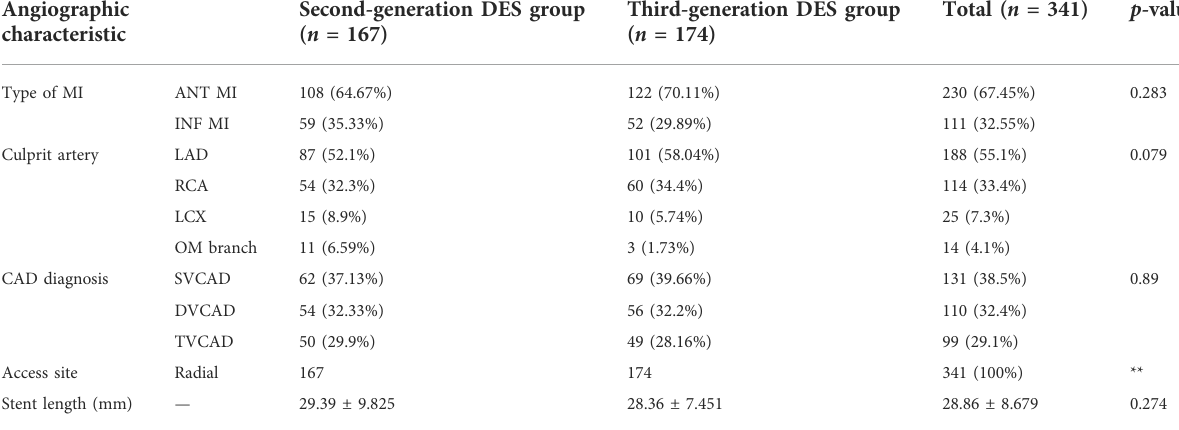
TABLE 2 Angiographic characteristics of the study participants. Angiographic